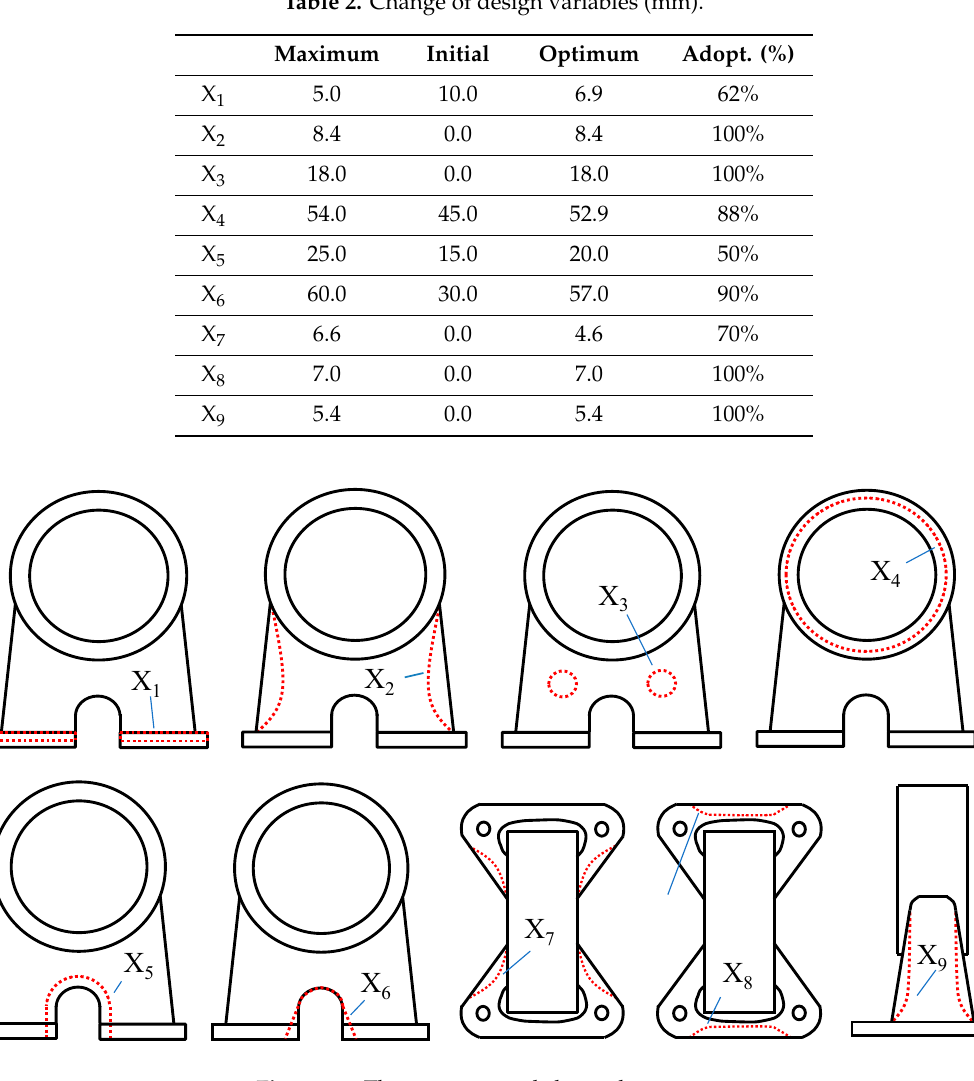
Figure 10. The structure and shape change area. Appl. Sci. 2020 , 10 , x FOR PEER REVIEW